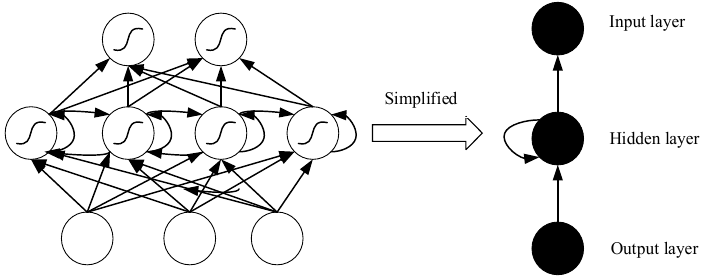
Figure 1. Recurrent Neural Network (RNN) model structure.